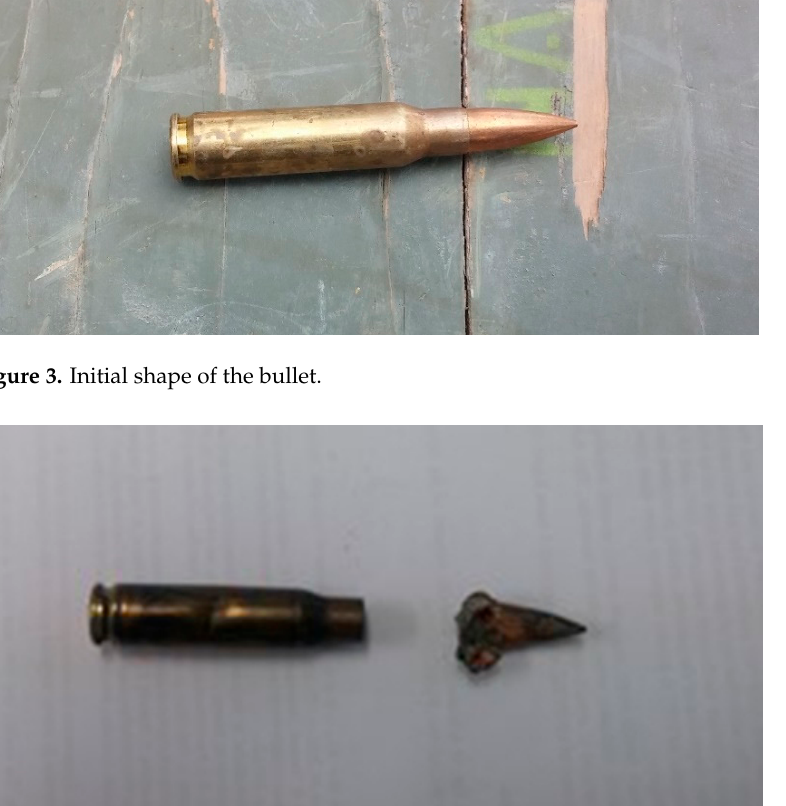
Figure 5. Failure type I—full penetration of the slab (front face at the left and rear face at the right ) . Reprinted/adapted by permission from Springer Nature: Springer Nature Switzerland AG, Mina, A.L.; Trezos, K.G.; Petrou, M.F. Mechanical Properties of Ultra High Performance Fibre Rei- forced Concrete and Its Response to Impact Loading. In Advanced Materials for Defense; Fangueiro, R.; Rana, S., Eds.; Springer: Cham, Switzerland, 2020; Volume 4, pp. 71–78.